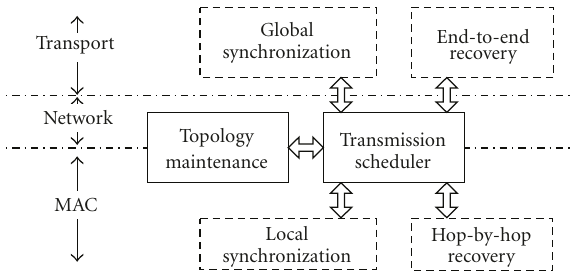
Figure 1: A generic architecture of a data gathering approach. Mandatory components are shown by solid squares and optional components are shown by dashed